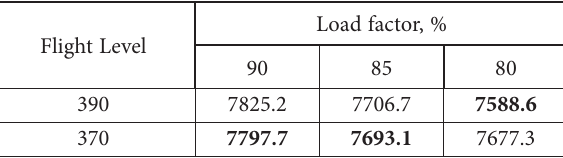
Table 8. Trip fuel in kg, 2500 km flight, ‘Deteriorated’